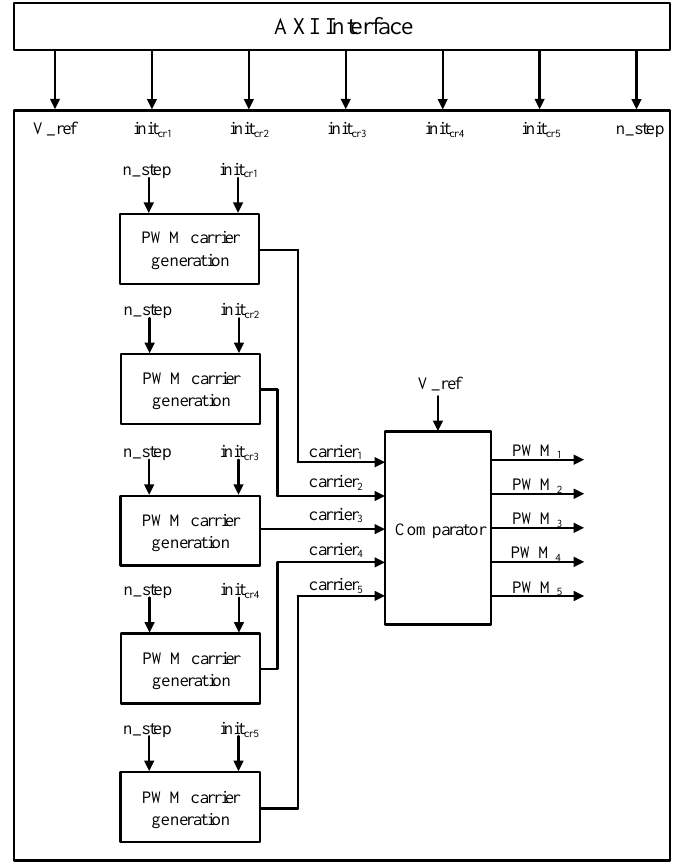
Figure 16. Block diagram per-arm of the implemented PS-SPWM.